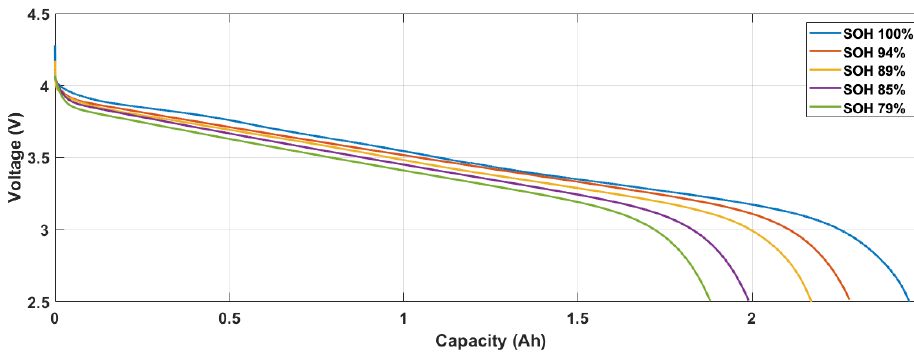
Figure 12. Discharge characteristics for 5 A a SoH = 100%, 94%, 89%, 85%,